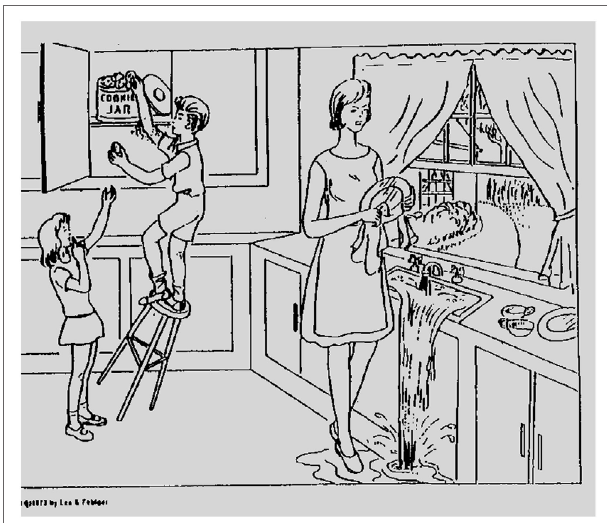
Table 1 | Acoustic measures that were included in the analyses.